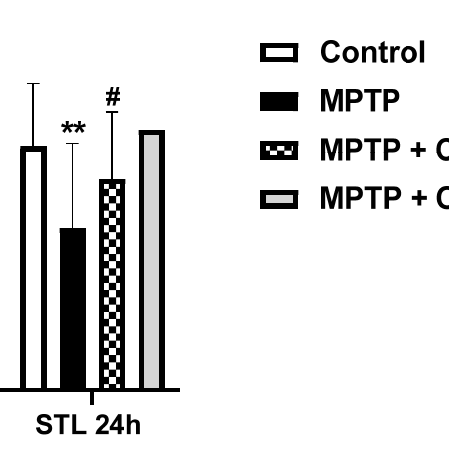
Figure 5. The effect of CA(2-Me)-Am on initial latency (IL) and step-through latency (STL) in a single-trial passive avoidance test in a mouse model of PD. Significance vs. control group: ** p < 0.01; significance vs. MPTP-treated group: # p < 0.05. Statistical analysis was performed by one-way analysis of variance (ANOVA), followed by Dunnett’s post hoc comparison test.